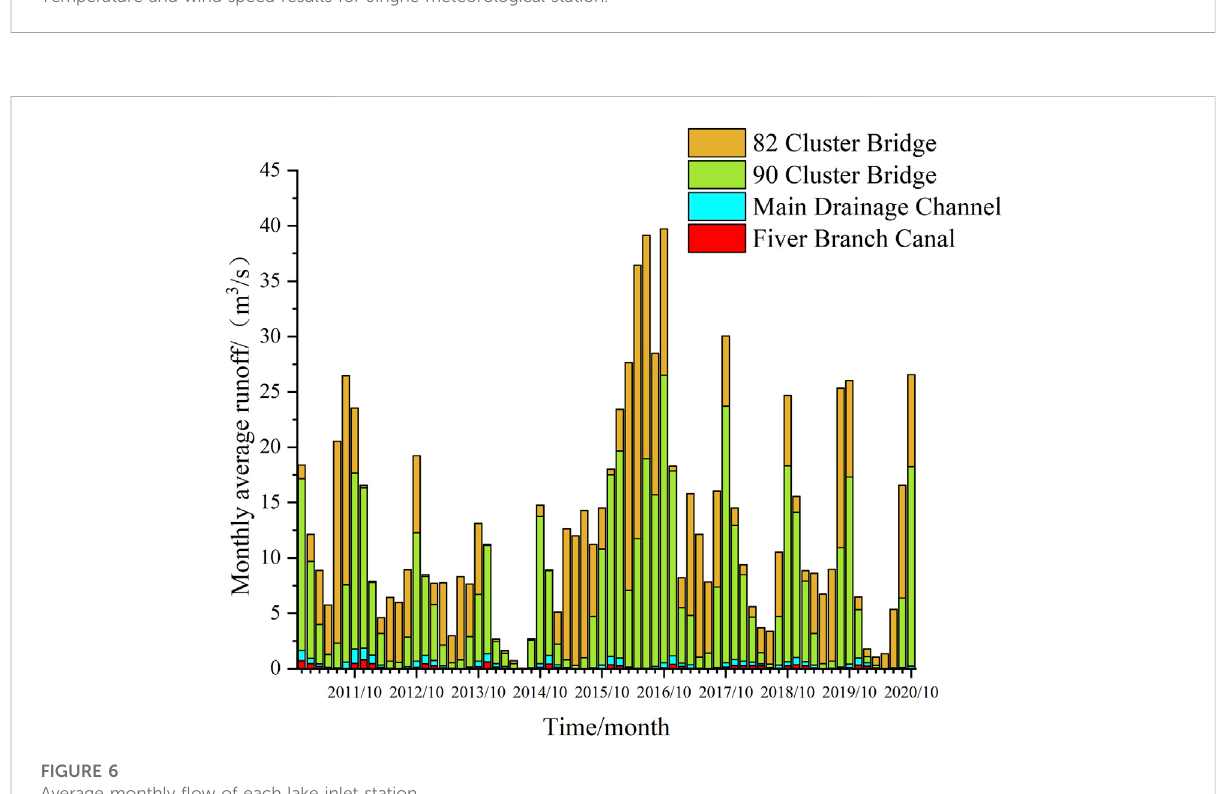
FIGURE 6 Average monthly fl ow of each lake inlet